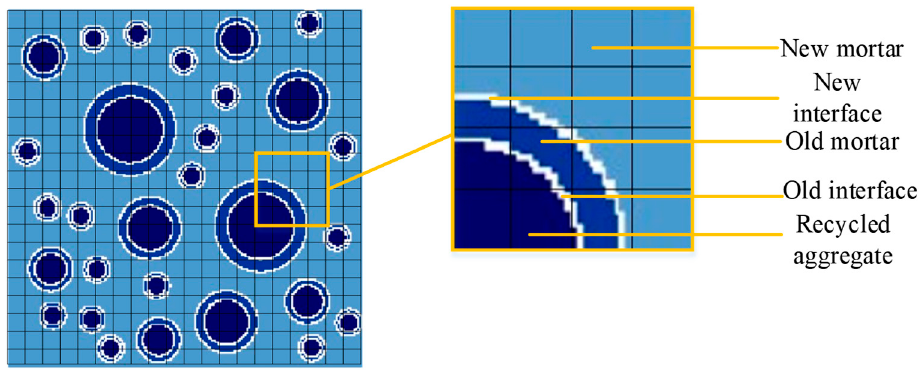
Figure 1. Each phase of random